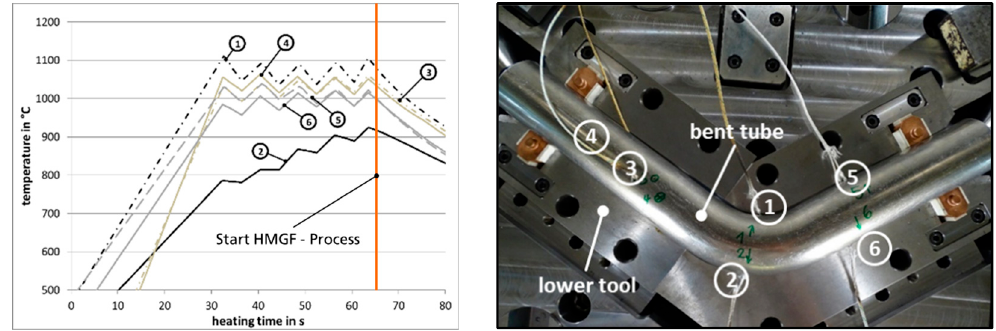
Figure 7. Heating curves during pulsing current; the numbers 1–6 indicate the positions of the thermal sensors.